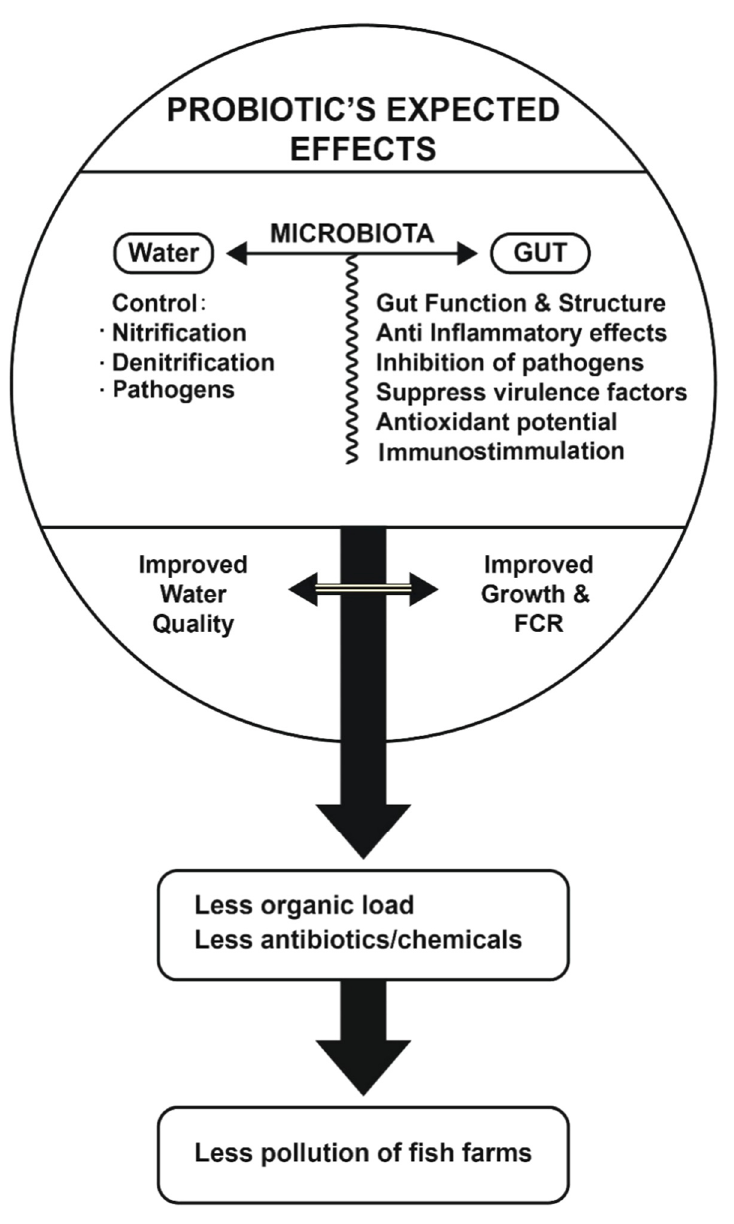
Figure 2. A flow diagram with the action of probiotics at the level of the aquatic ecosystem and at the organism level, resulting in improved fish health, feed conversion, and growth, and reduction of freshwater aquaculture pollution.